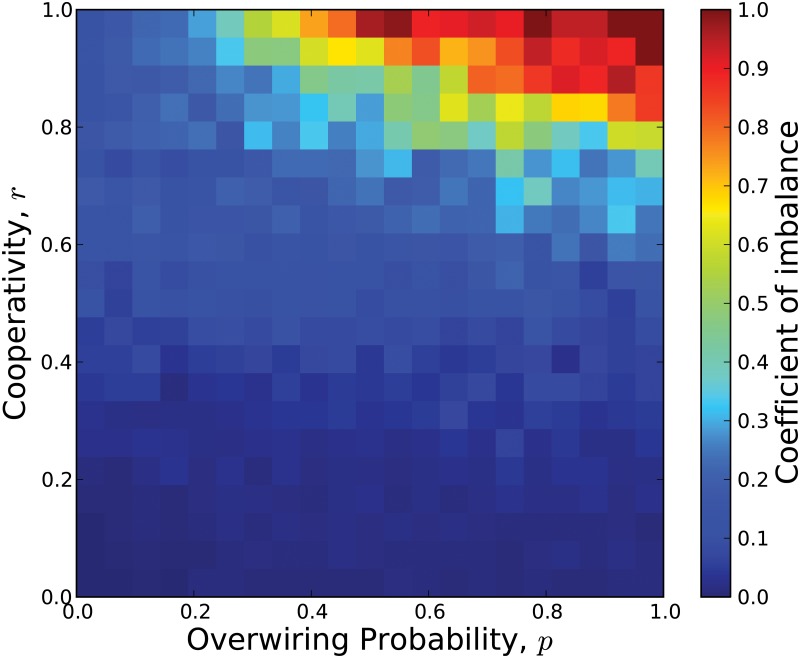
Coefficient of imbalance (CI) for several configurations of conflict actor networks.The phase space of the over-wiring probability p vs. the cooperativity ratio r is depicted. For low values of r, the final steady-states are close to the value ϕ ≈ 0, i.e., the averaged states of positive actors is almost equal to the negative ones or viceversa. The value of CI is represented according to the color bar.